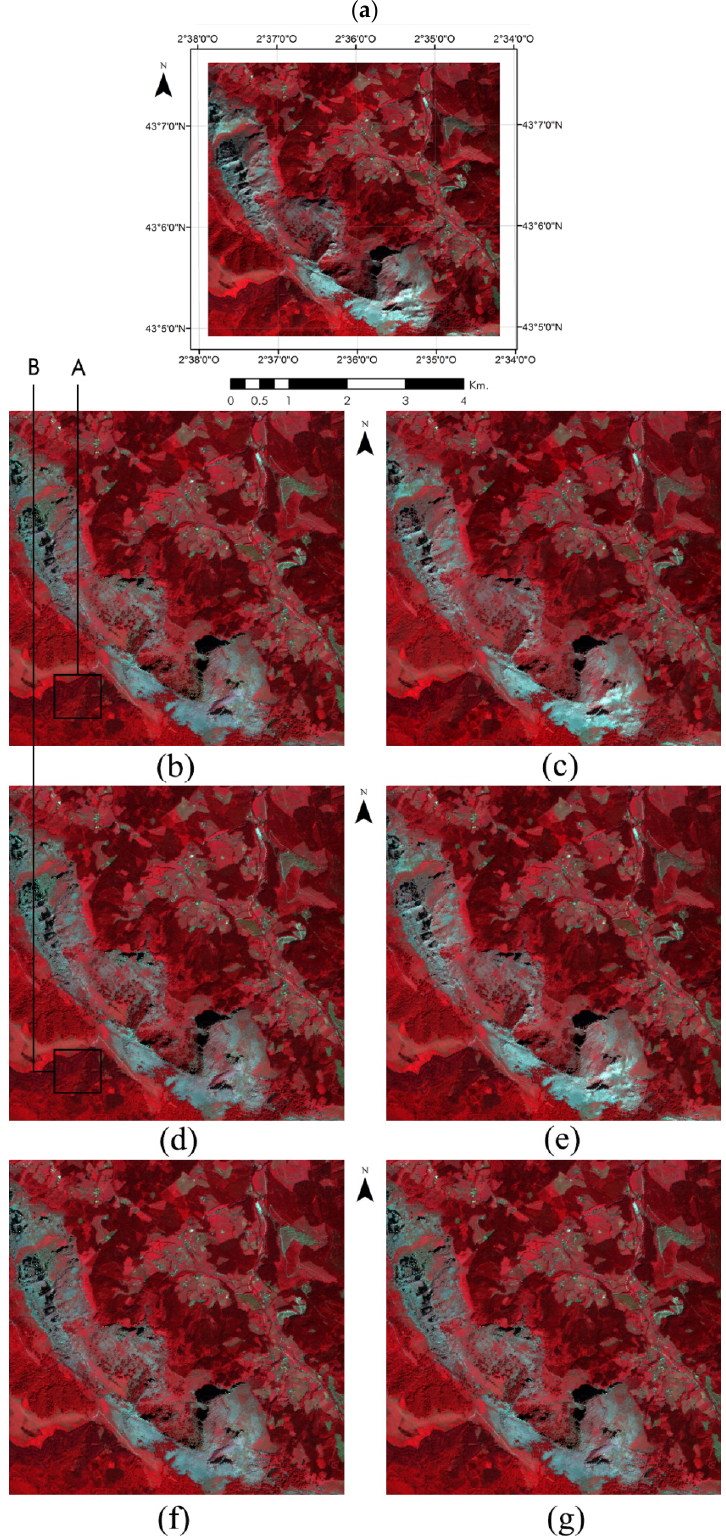
Figure 2. Detail zone with ( a ) Uncorrected scene; ( b ) SCS+C-corrected scene with no stratification; ( c ) SE-corrected scene with no stratification; ( d ) SCS+C-corrected scene with LC-8 stratification; ( e ) SE-corrected scene with LC-8 stratification; ( f ) SCS+C-corrected scene with NDVI-8 stratification; ( g ) SE-corrected scene with NDVI-8